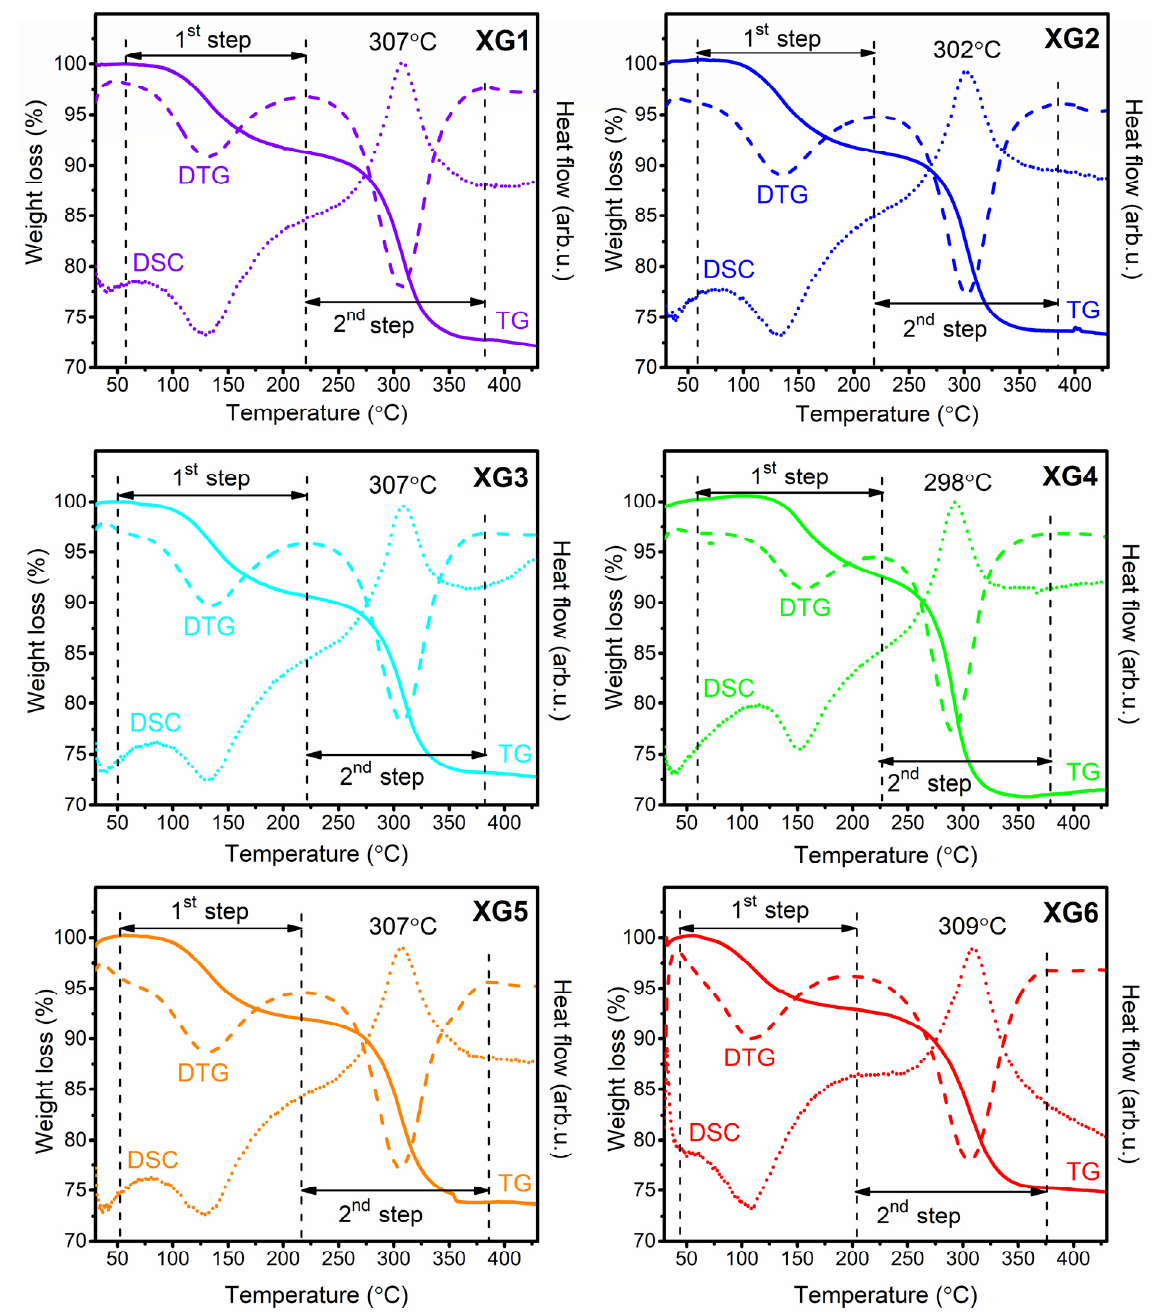
Figure 1. TG, DSC and DTG curves recorded for prepared XG1-XG6 xerogels (presented as solid, dashed, and dotted lines, respectively).